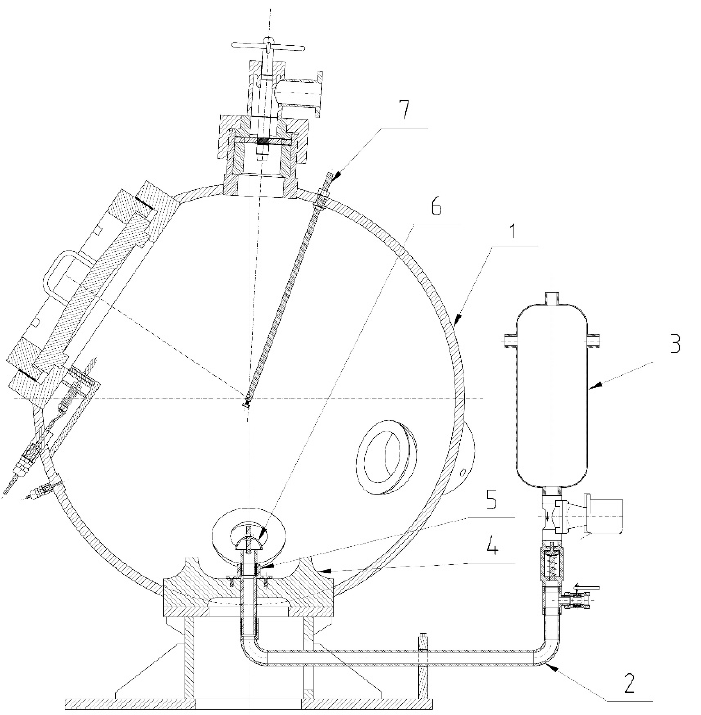
Figure 1. Cross section of 365 L explosion chamber (1—explosion spherical chamber, 2—disperser tube, 3—pressure vessel, 4—dispersing plate, 5, 6—disperser, 7—igniter rod) (Reprinted Ref. [25]). Lycopodium clavatum was used as a standard sample, Figure 3. Explosion parameters of Lycopodium clavatum were measured in the KV 150M2 chamber. Explosion parameters of the sample of magnesium powder ( − 325 mesh, up to 45 µ m) and benzoic acid were tested in the 20 L sphere explosion chamber, Figure 1. The parameters to be compared were measured at the concentrations of 250 and 500 g · m − 3 , and also at the concentrations of 750 and 1000 g · m − 3 in the case of benzoic